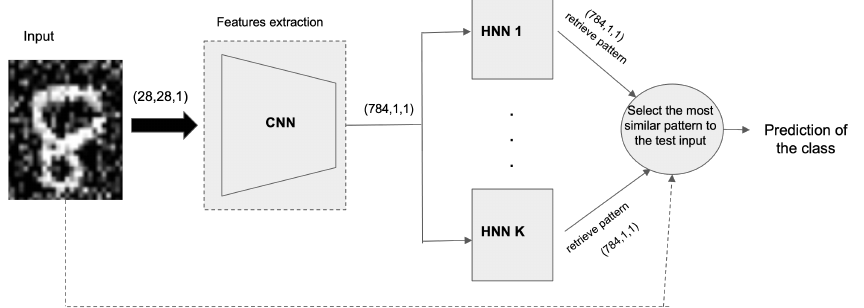
Figure 5. Illustration of the relationship between the genetic algorithm and the CNN at the infer- ence